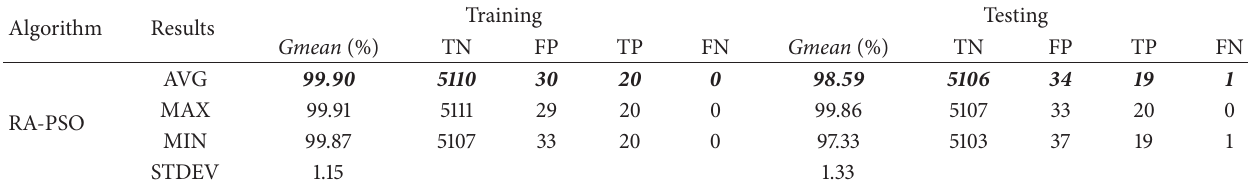
Table 14: Average training and testing results of 10 runs with feature selection using